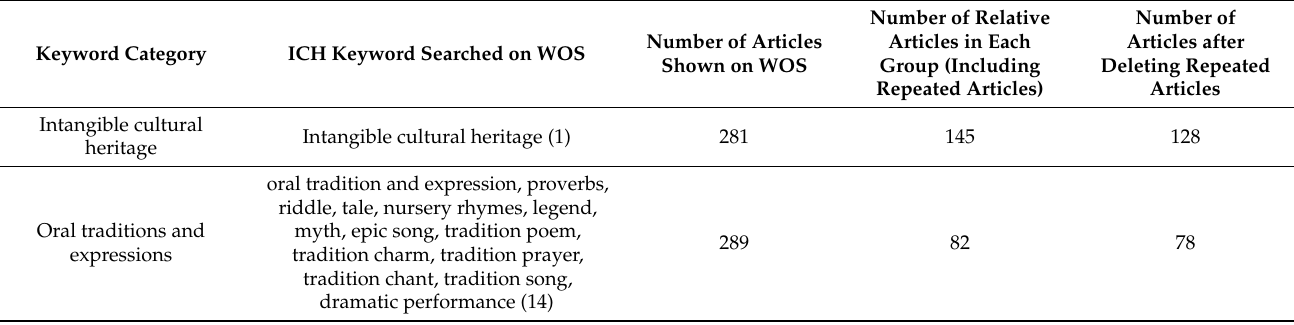
Table A1. ICH keywords, number of articles shown on WOS and articles related to the